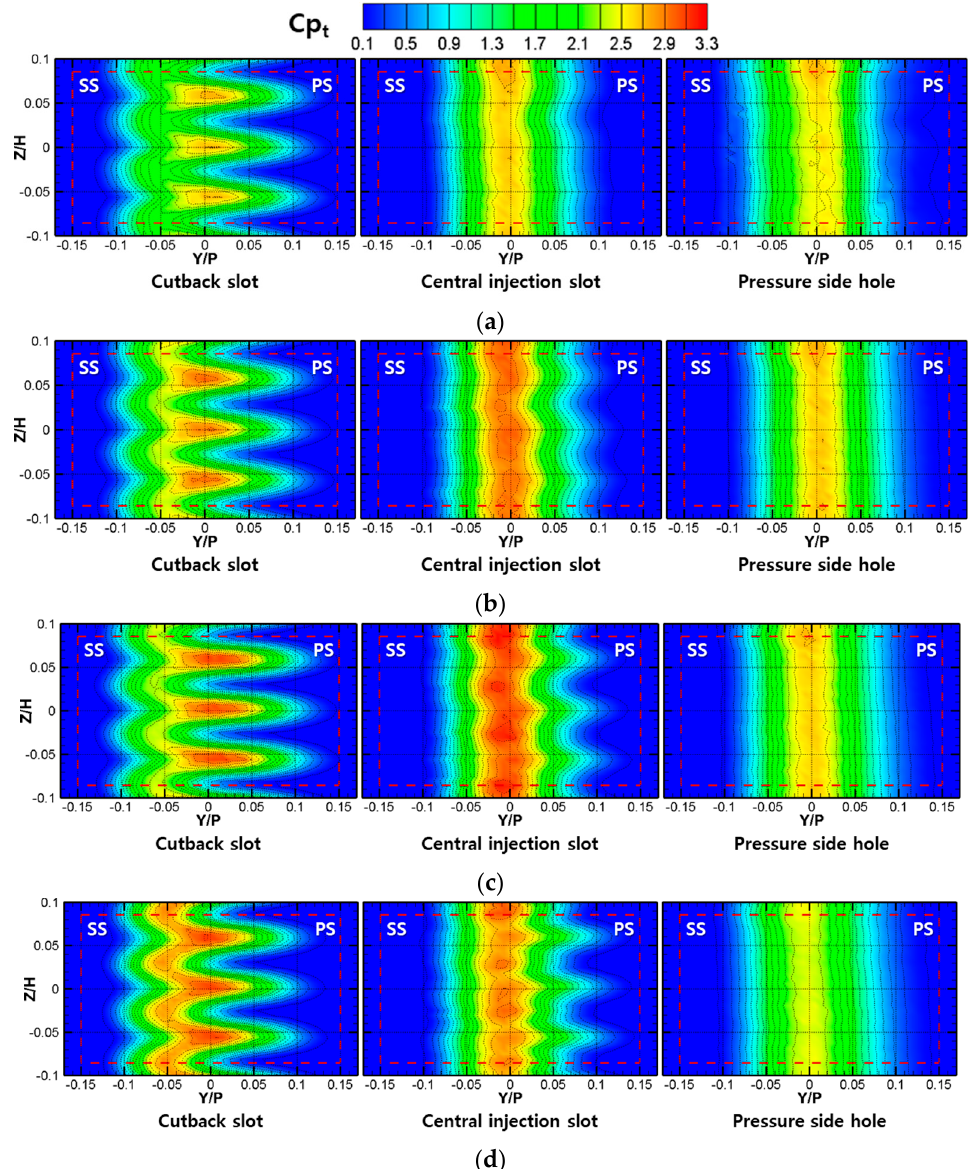
Figure 10. Distribution of the total pressure loss coefficient of the vane trailing edge diameter of d (cid:2904)(cid:2889) /T = 7 .5% at different blowing ratios: ( a ) M = 0.0; ( b ) M = 1.0; ( c ) M = 2.0; ( d ) M = 3.0.